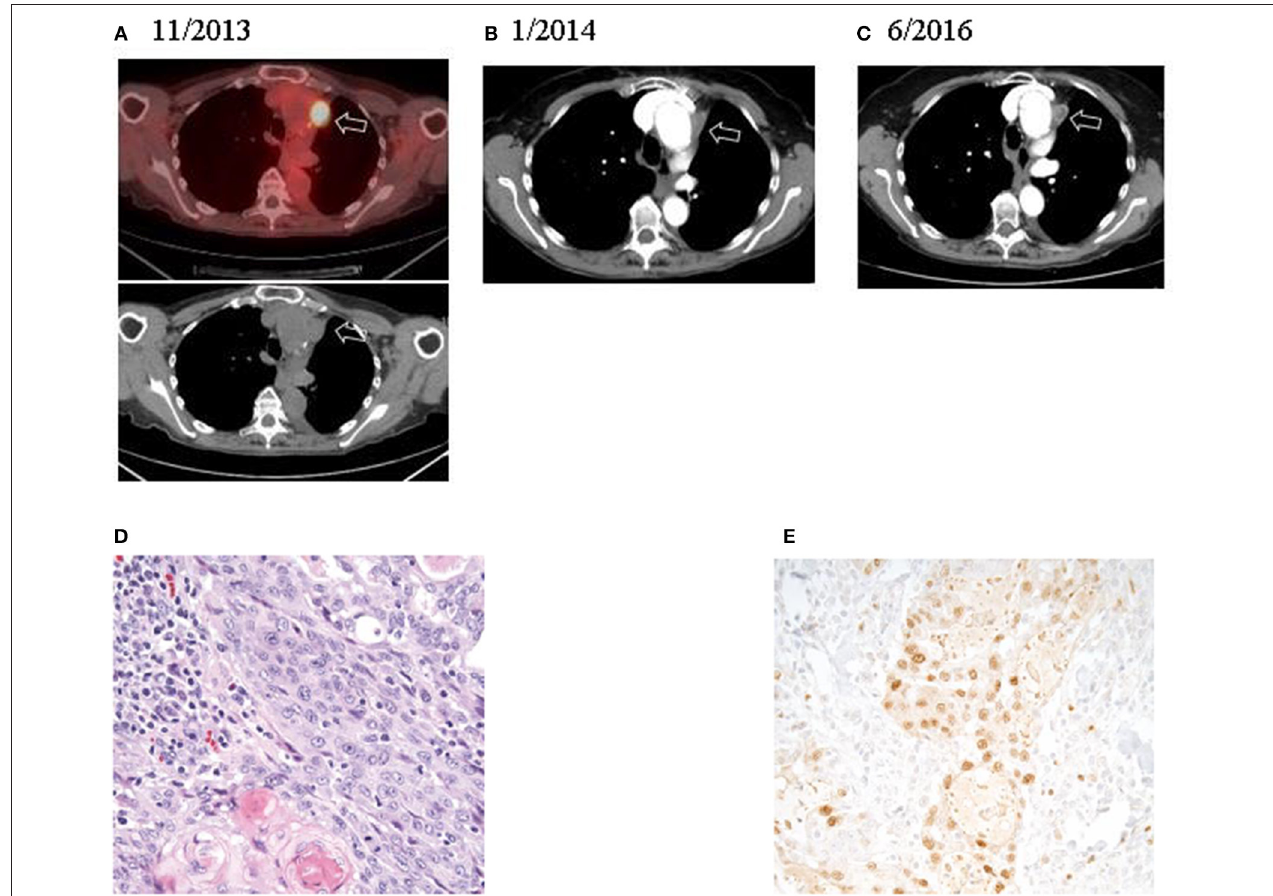
TABLE 1 | Patient population and treatment results.